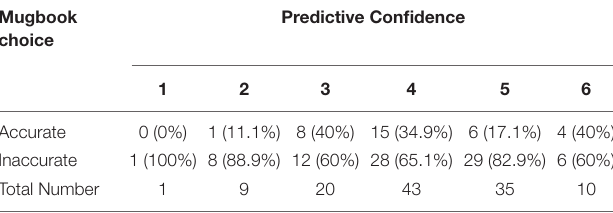
TABLE 5 | Identification accuracy according to the predictive confidence level. Mugbook